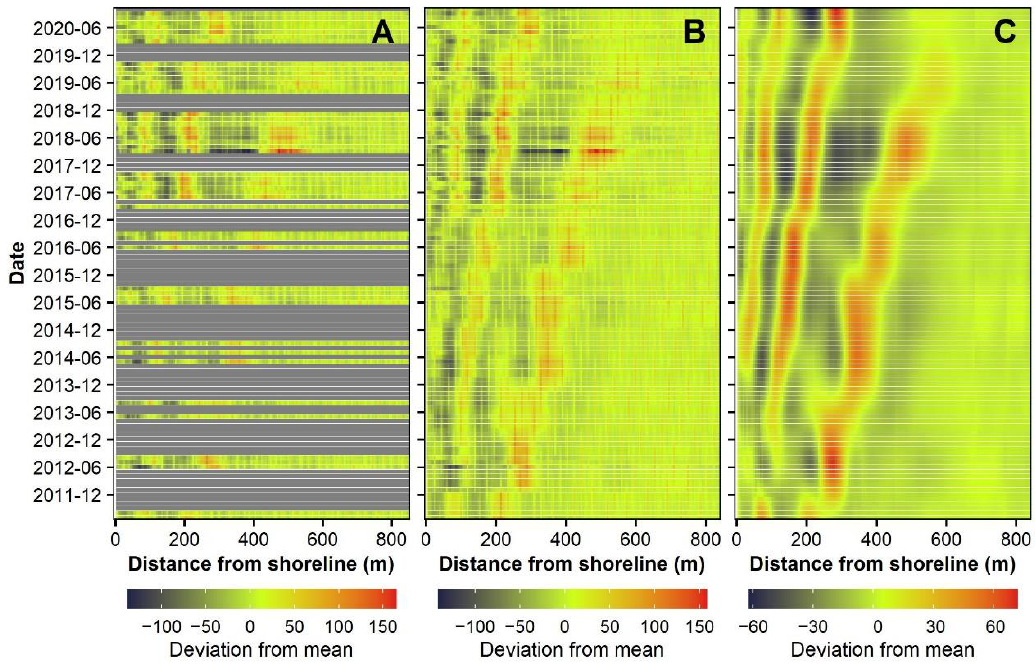
Figure 4. Space-time maps of perturbations in a single cross-shore profile of Relative Bathymetric Position Index (RBPI): ( A ) gappy monthly data (gaps are marked in grey); ( B ) data filled with a linear-weighted moving average; ( C ) data filtered with fast Fourier transform and discrete wavelet transform.